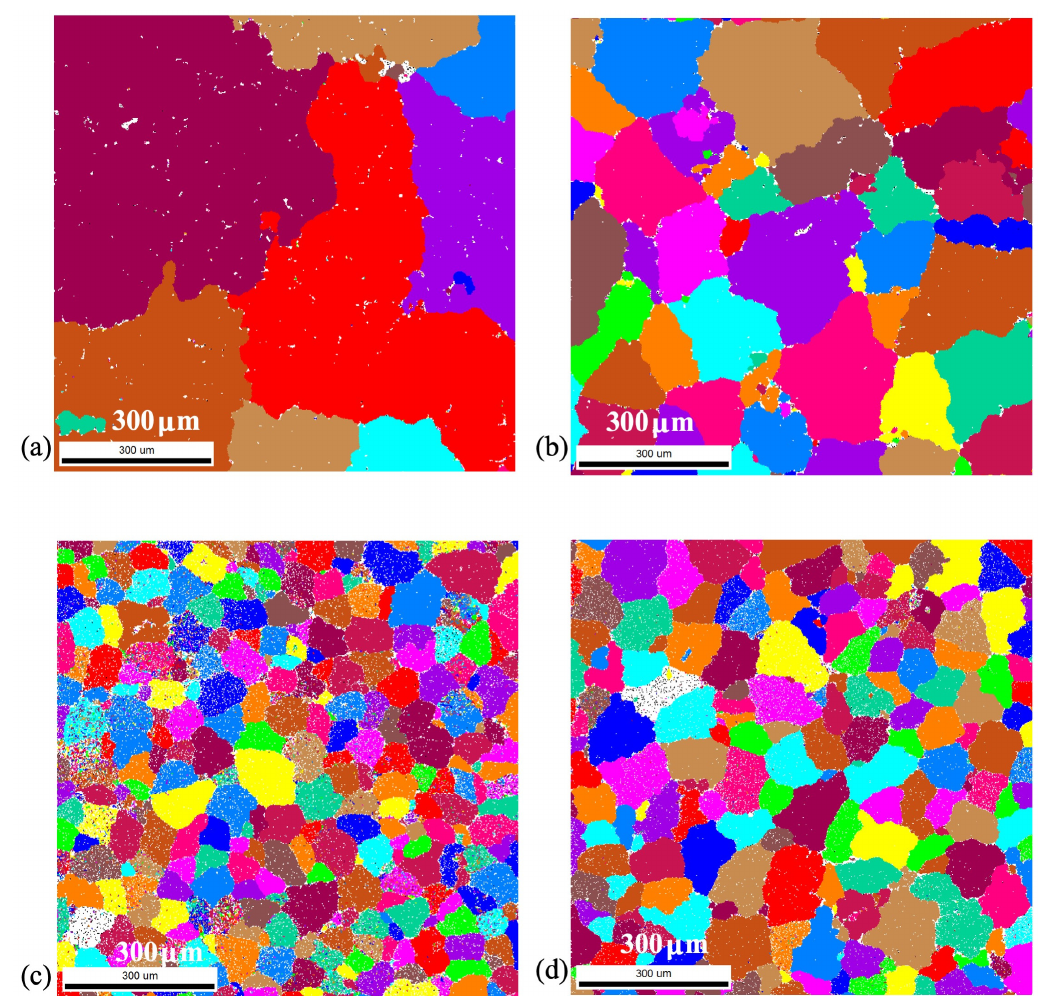
Figure 3. Typical as-aged EBSD microstructure for the DA2 alloy for the ( a ) non-grain-refined condition and grain-refined conditions with ( b ) 0.02, ( c ) 0.1, and ( d ) 0.2 wt.% Ti.